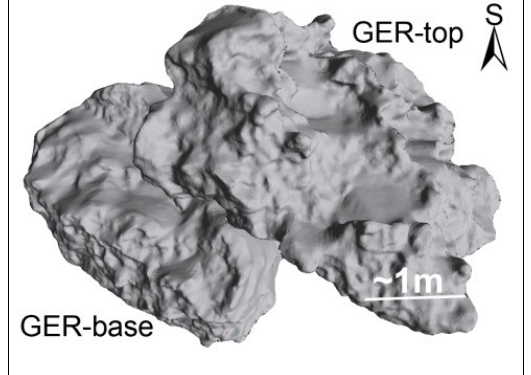
Figure 2. Perspective view of two boulders of Katakolo, lying on top of each other.